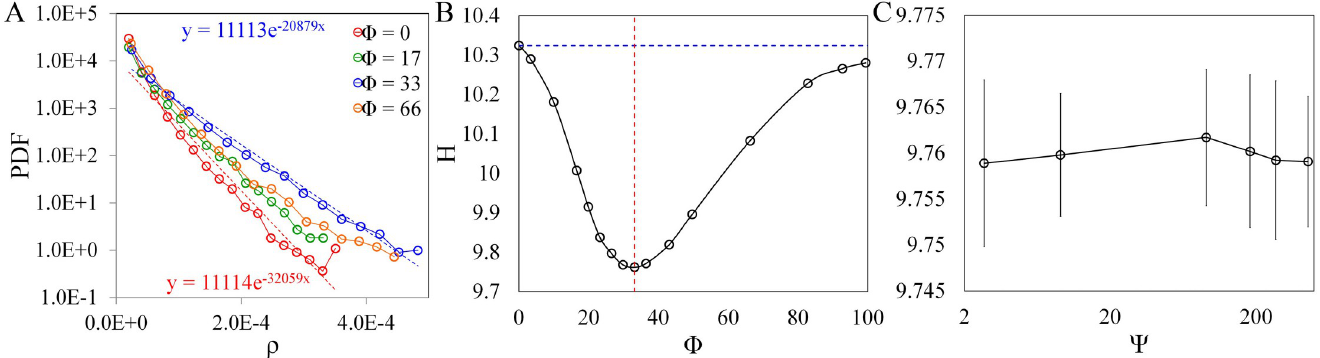
Fig 3. Particle density PDF and entropy. (A) Particle density PDF when Re λ = 59 for different swimming numbers F = [0, 17, 33, 66]. (B) Changes in entropy H with swimming number at C = 91 (vertical dashed line for F = 33). (C) Entropy H as a function of stability number at F = 33. Error bars taken across 250-time steps.